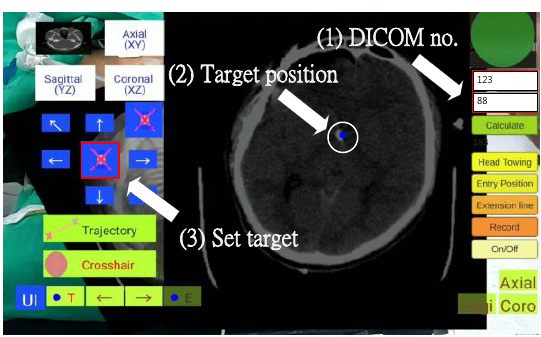
Figure 11. Find and set target position.